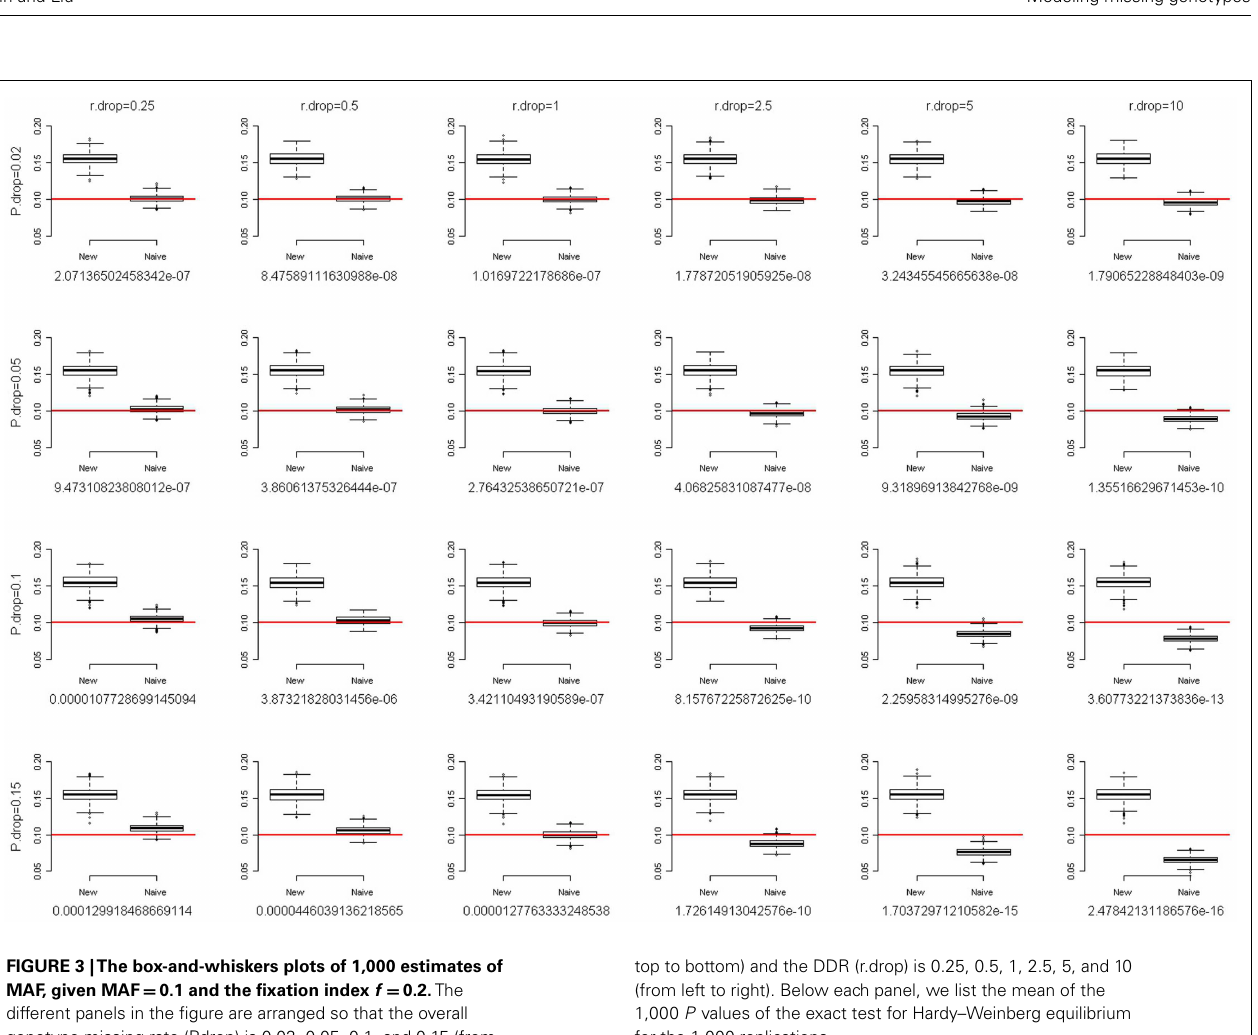
top to bottom) and the DDR (r.drop) is 0.25, 0.5, 1, 2.5, 5, and 10 (from left to right). Below each panel, we list the mean of the 1,000 P values of the exact test for Hardy–Weinberg equilibrium for the 1,000